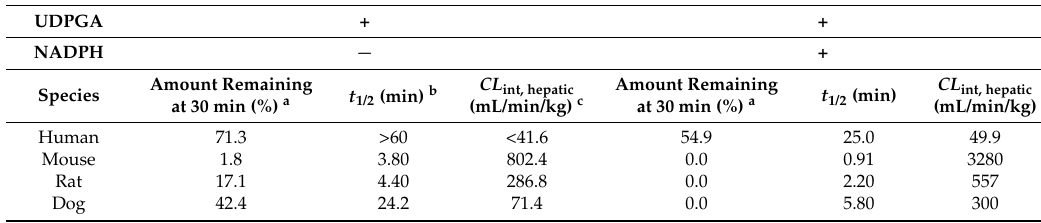
Table 2. Uridine 5 (cid:48) -diphosphoglucuronic acid (UDPGA)-dependent metabolic stability of sakuranetin (SKN) in liver microsomes from four different species.